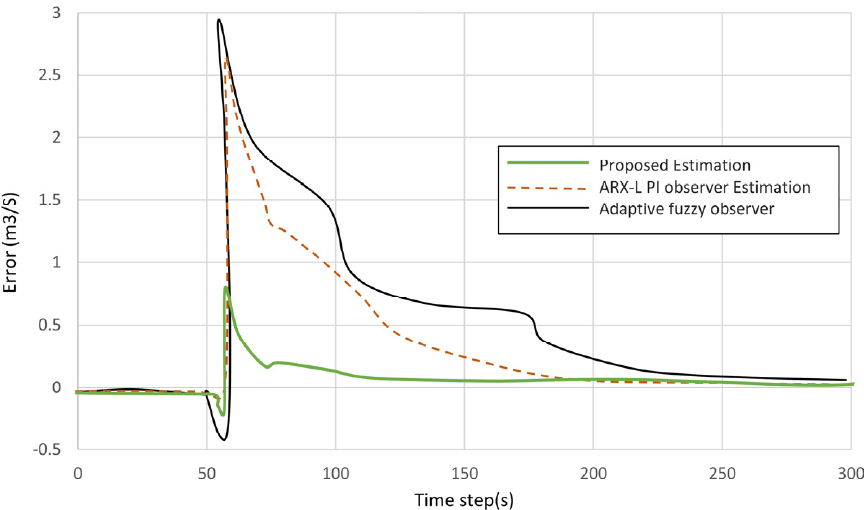
Figure 6. The error between the predicted output and the expected output based on the proposed technique under no-fault condition.